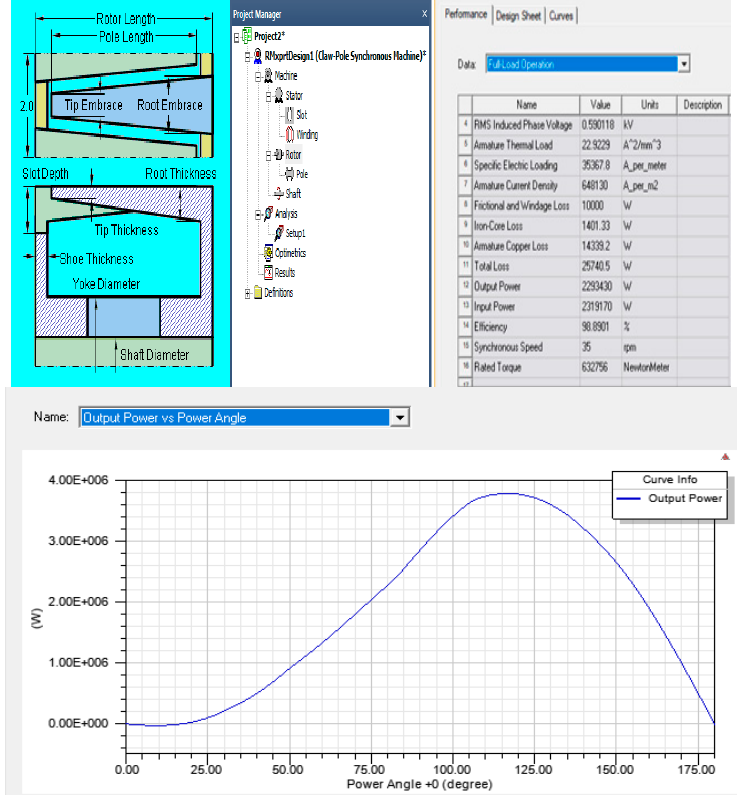
Figure 4. The results of the CPSM in the mode RMxprt . [1]